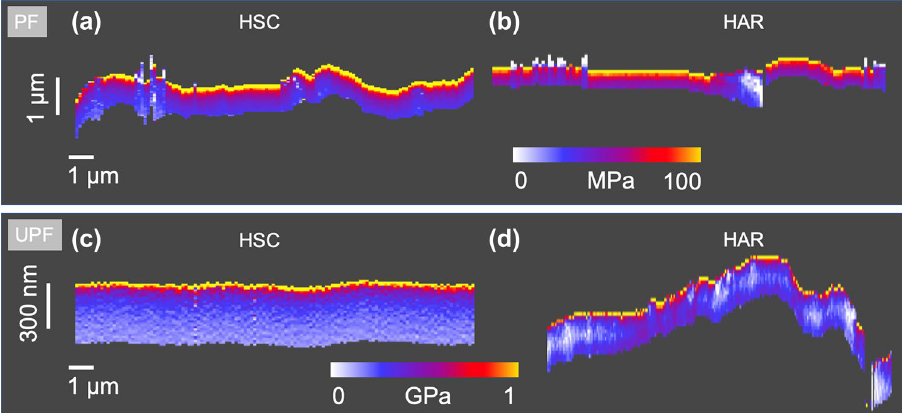
Fig. 4 Depth profile of Elok(z) in the xz-direction of a PF mapped with an HSC cantile- ver in ( a ) and an HSC cantilever in ( b ) and of UPF mapped with an HSC cantilever in ( c ) and an HAR cantilever in ( d